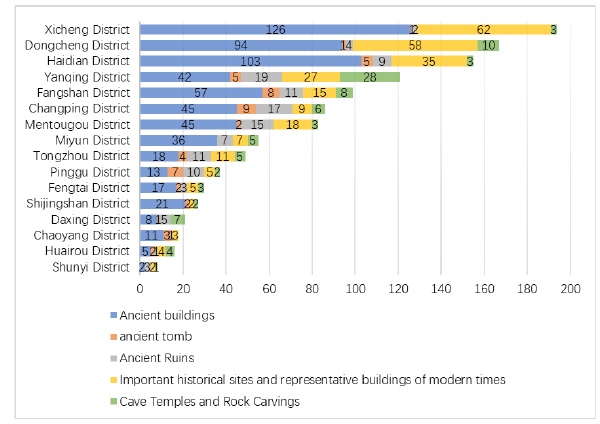
Figure 2 . Statistical bar chart of Beijing's cultural preservation units by